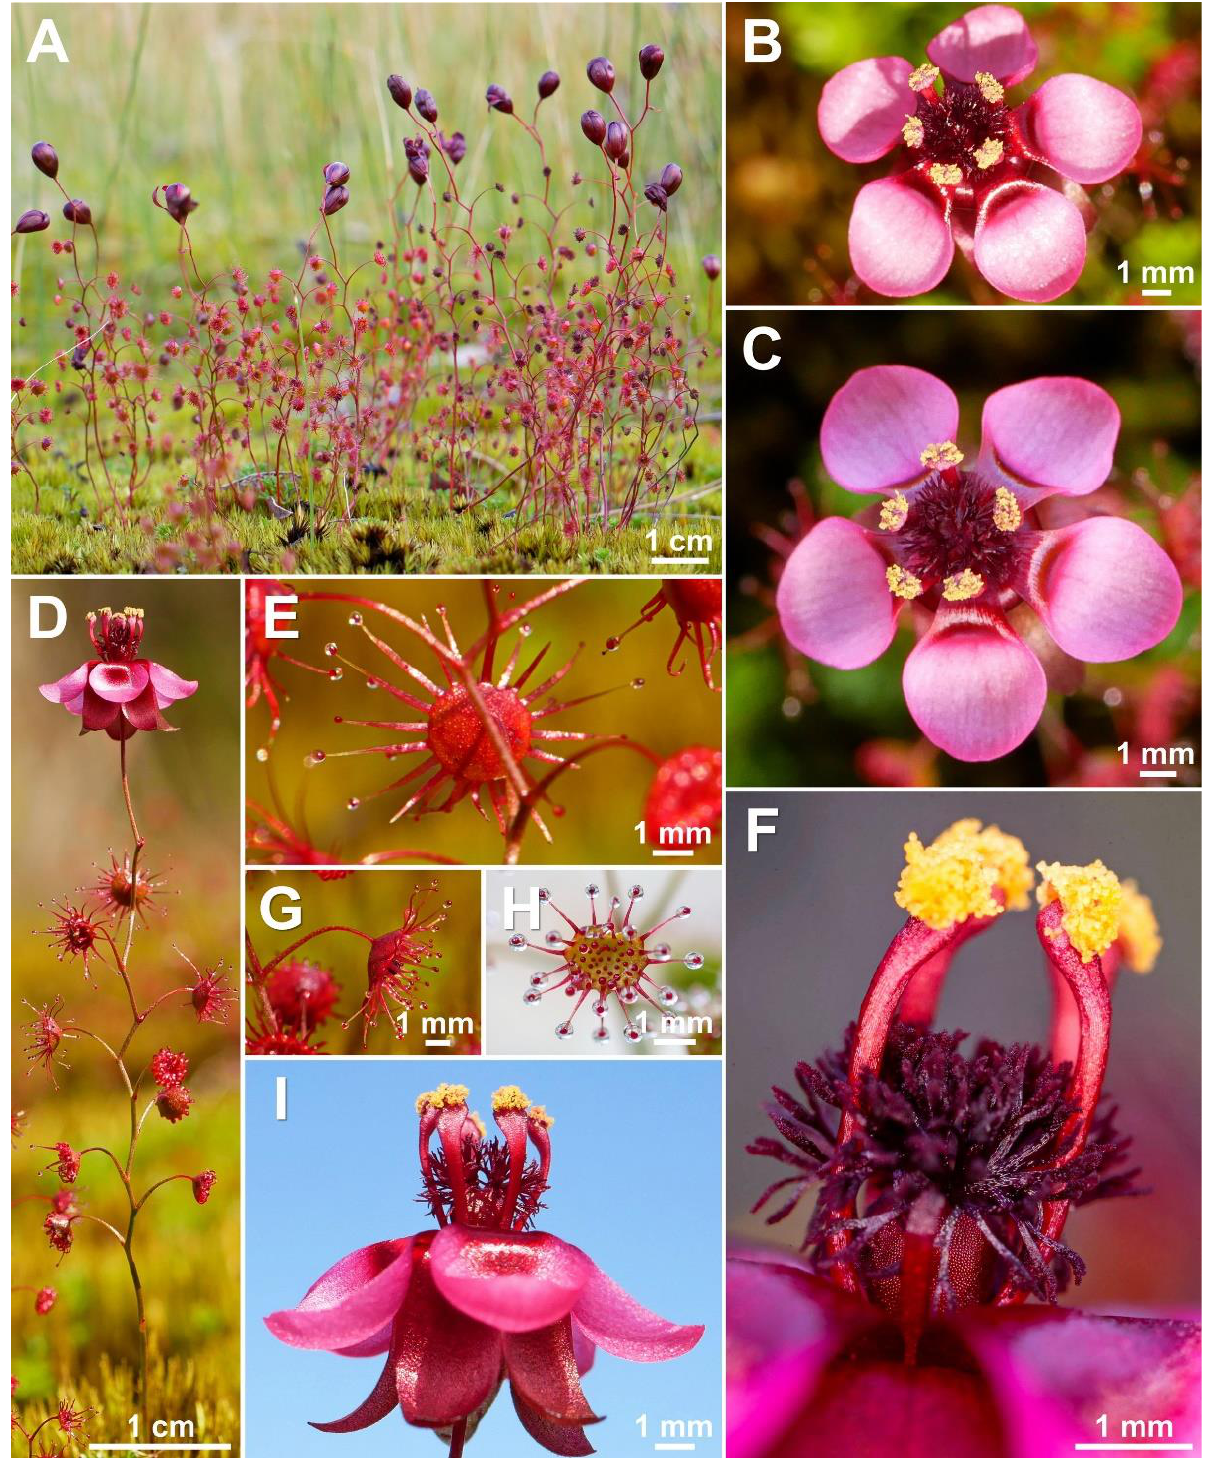
Figure 16. Drosera reflexa G.Bourke & A.S.Rob. ( A ) group of plants; ( B ) flower in bright sunlight; ( C ) flower in diffuse light; ( D ) habit; ( E ) lamina, abaxial view; ( F ) stamens and styles; ( G ) petiole and lamina, lateral view; ( H ) juvenile lamina, adaxial view; and ( I ) flower, lateral view. ( A – E , G , I ) from near Kentdale, Western Australia, 26 August 2022; images by T. Krueger. ( F , H ) from cultivated material originating from near Kentdale, Western Australia; images by G. Bourke.